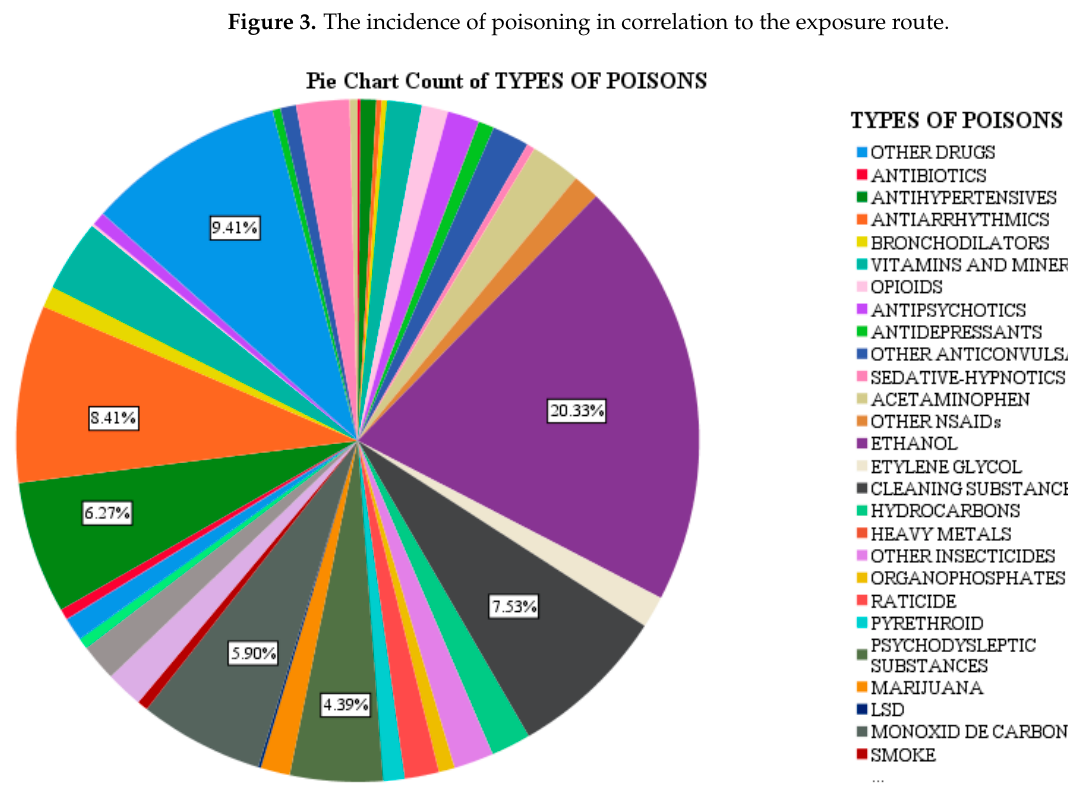
Figure 4. Types of poisons in the studied batch .